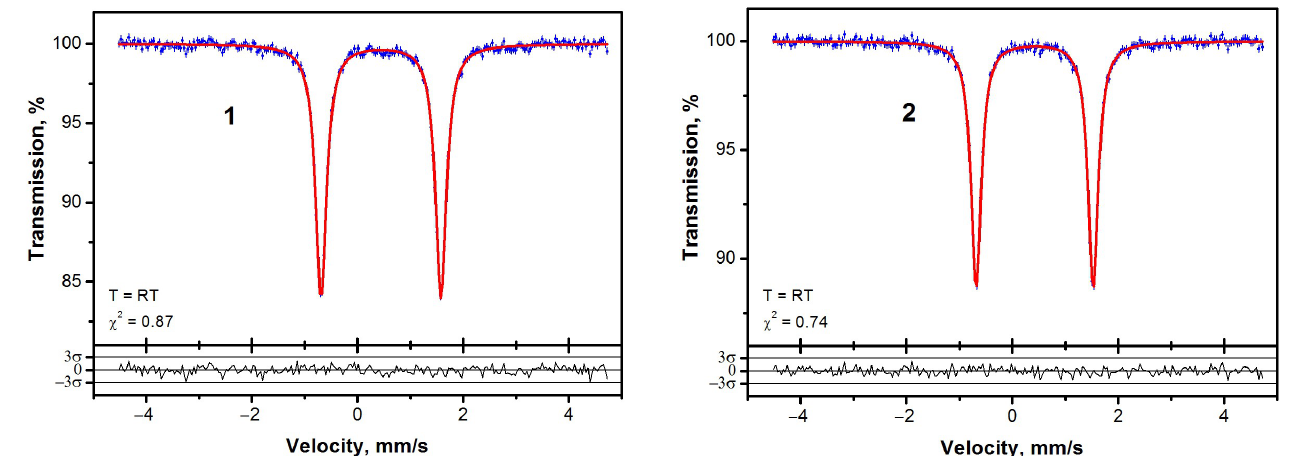
Figure 8. Mössbauer spectra of 1 ( left ) and 2 ( right ) recorded at room temperature. QS is determined by the electric field gradient (EFG) on iron nuclei. The main source of the EFG is electrons in the 3 d shell. Thus, the reduction in QS for 2 should be related to the changes in the 3 d orbitals relative population. However, the total occupation of these orbitals should not alter significantly since the central shift values are almost the same. The positive sign of EFG for ferrocene was reported in [30]. Therefore, considering known values of angular parts of 3 d wavefunctions [31], we may suppose that the